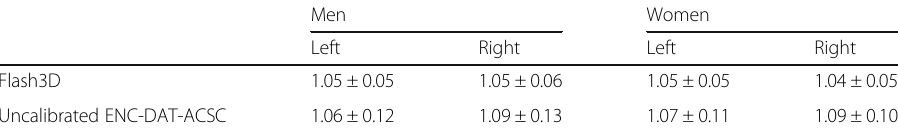
Table 9 Comparison of C/P ratios from the Flash3D database with those from the ENC-DAT study with BRASS analysis of uncalibrated and ACSC